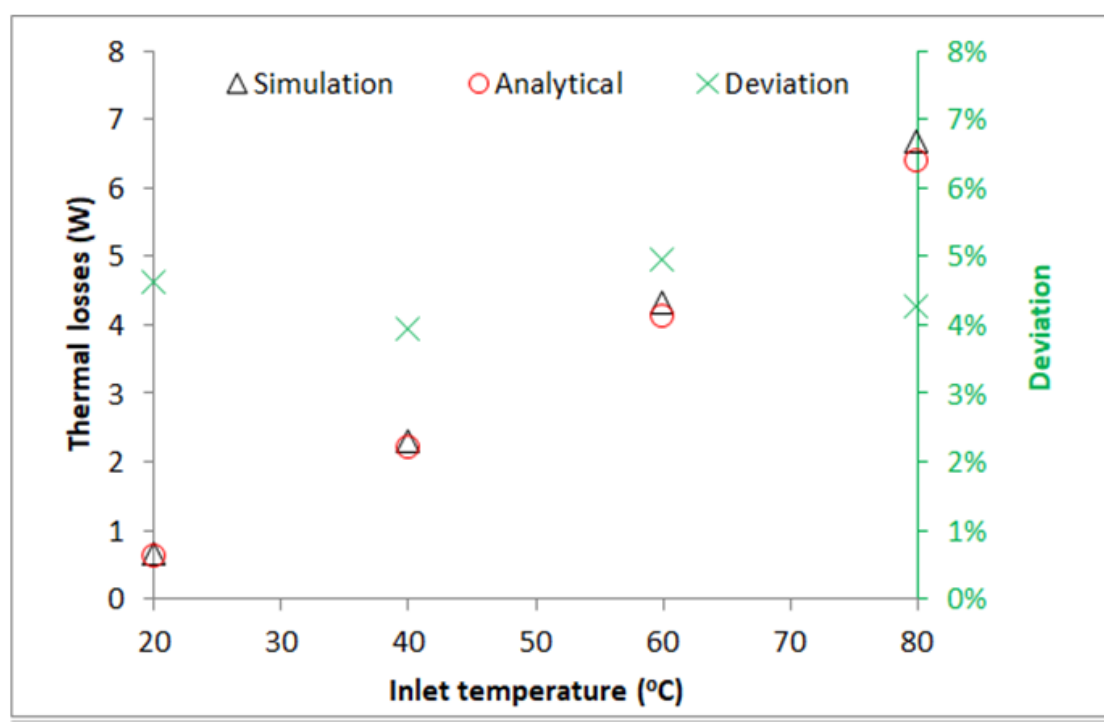
Figure 5. Verification regarding the thermal losses.